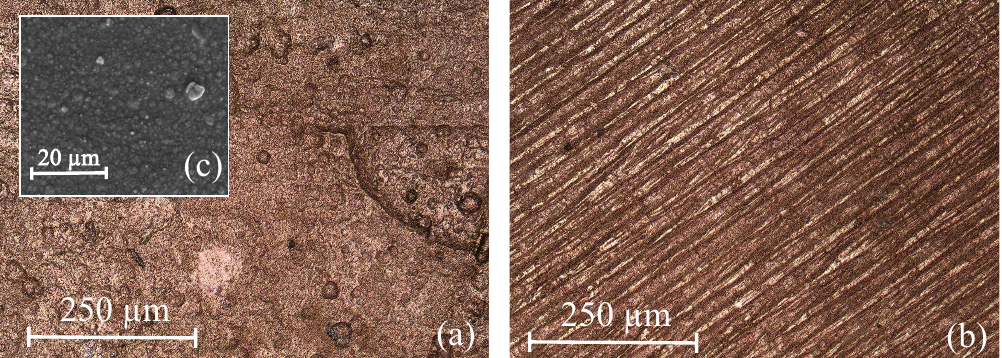
Figure 5. Polished cross-sections of a ceramic ( a , b ) and epoxy resin printed ( c , d ) WR12 waveguide.